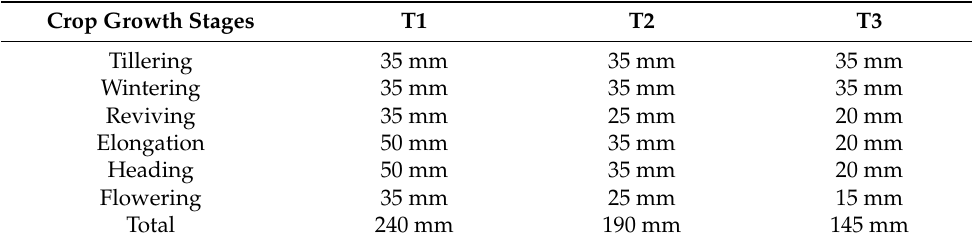
Table 1. An overview of the water treatment for the 2019–2020 growing season.